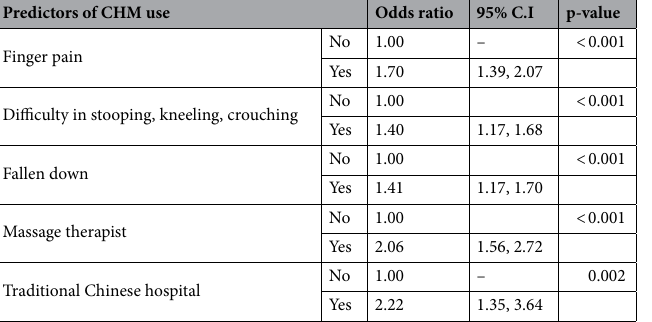
Predictors of CHM